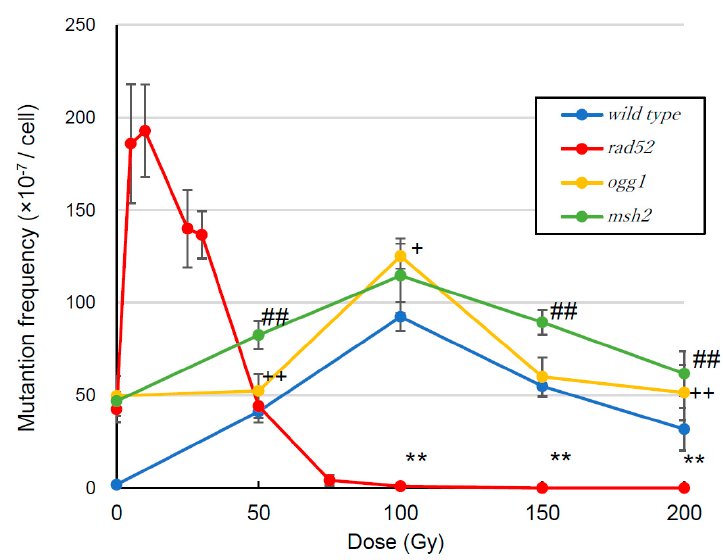
Figure 2. Mutation frequency for yeast strains S288c (wild-type), rad52 , ogg1 , and msh2 after irradiation with carbon ion beams. Data are the means of five replicates. Data for yeast strain S288c (wild-type) were taken from [12]. Bars indicate the SD. rad52 vs. wild-type; ** P < 0.01, ogg1 vs. wild-type; + P < 0.05, ++ P < 0.01, msh2 vs. wild-type; ## P < 0.01, at 50 Gy, 100 Gy, 150 Gy, and 200 Gy,